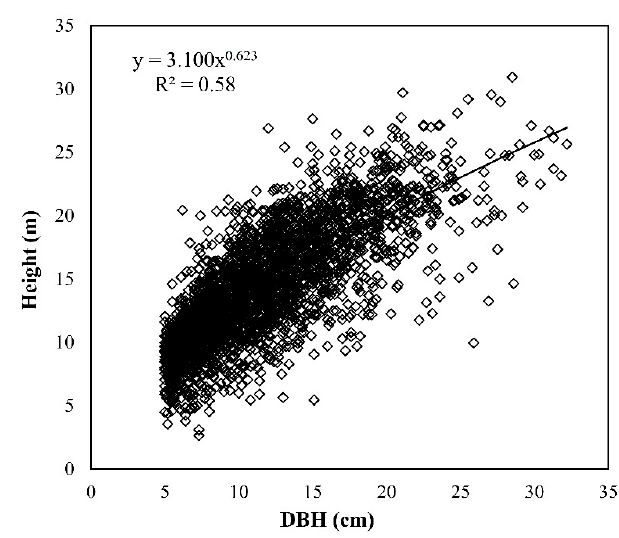
Figure 3. DBH and height relationship of mangrove trees in Sabah ( n = 2760).